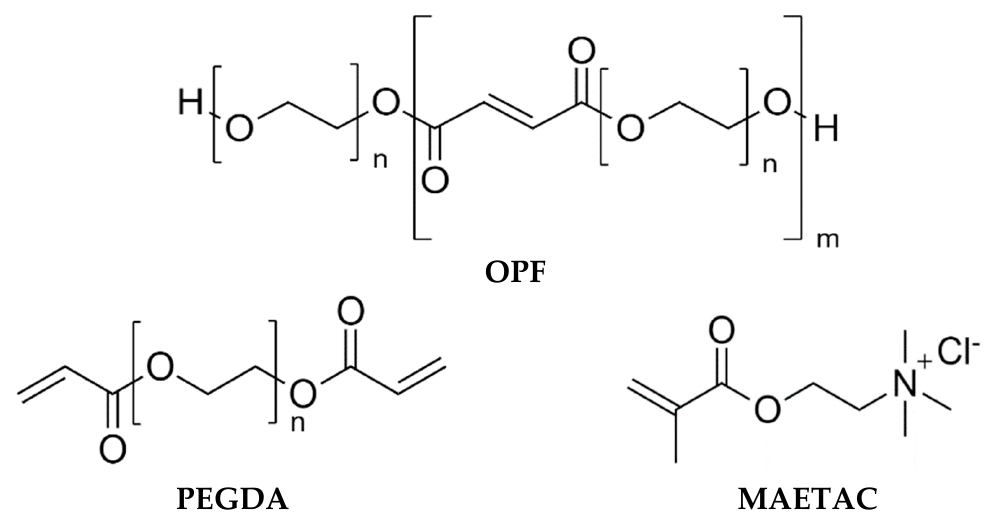
Figure 1. Chemical structures of cryogel constituents: oligo (poly (ethylene glycol) fumarate) (OPF), polyethylene glycol diacrylate (PEGDA), and 2-(methacryloyloxy)ethyl-trimethylammonium chlo- ride (MAETAC).